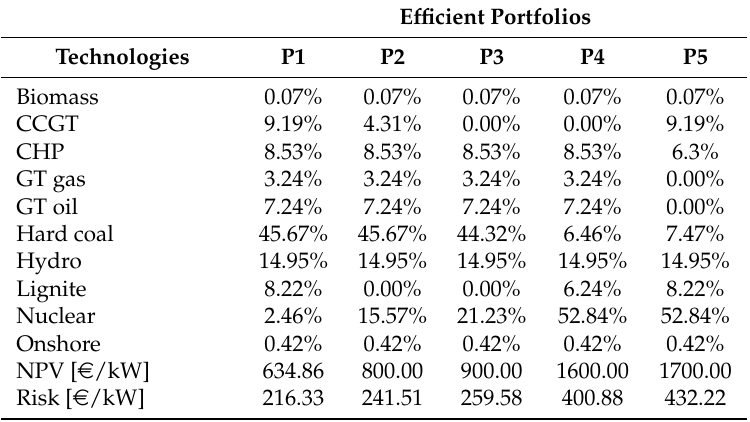
Table A9. Efficient portfolios according to the SMAD Model for existing